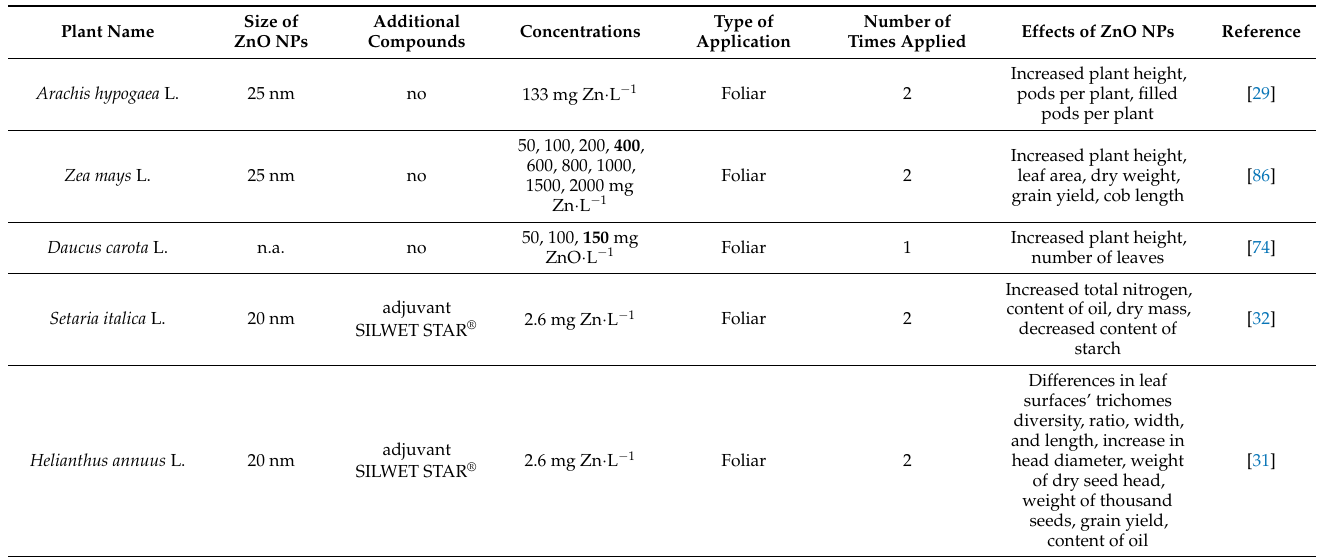
Table 1. Effects of ZnO NPs in higher plants grown under the field conditions.